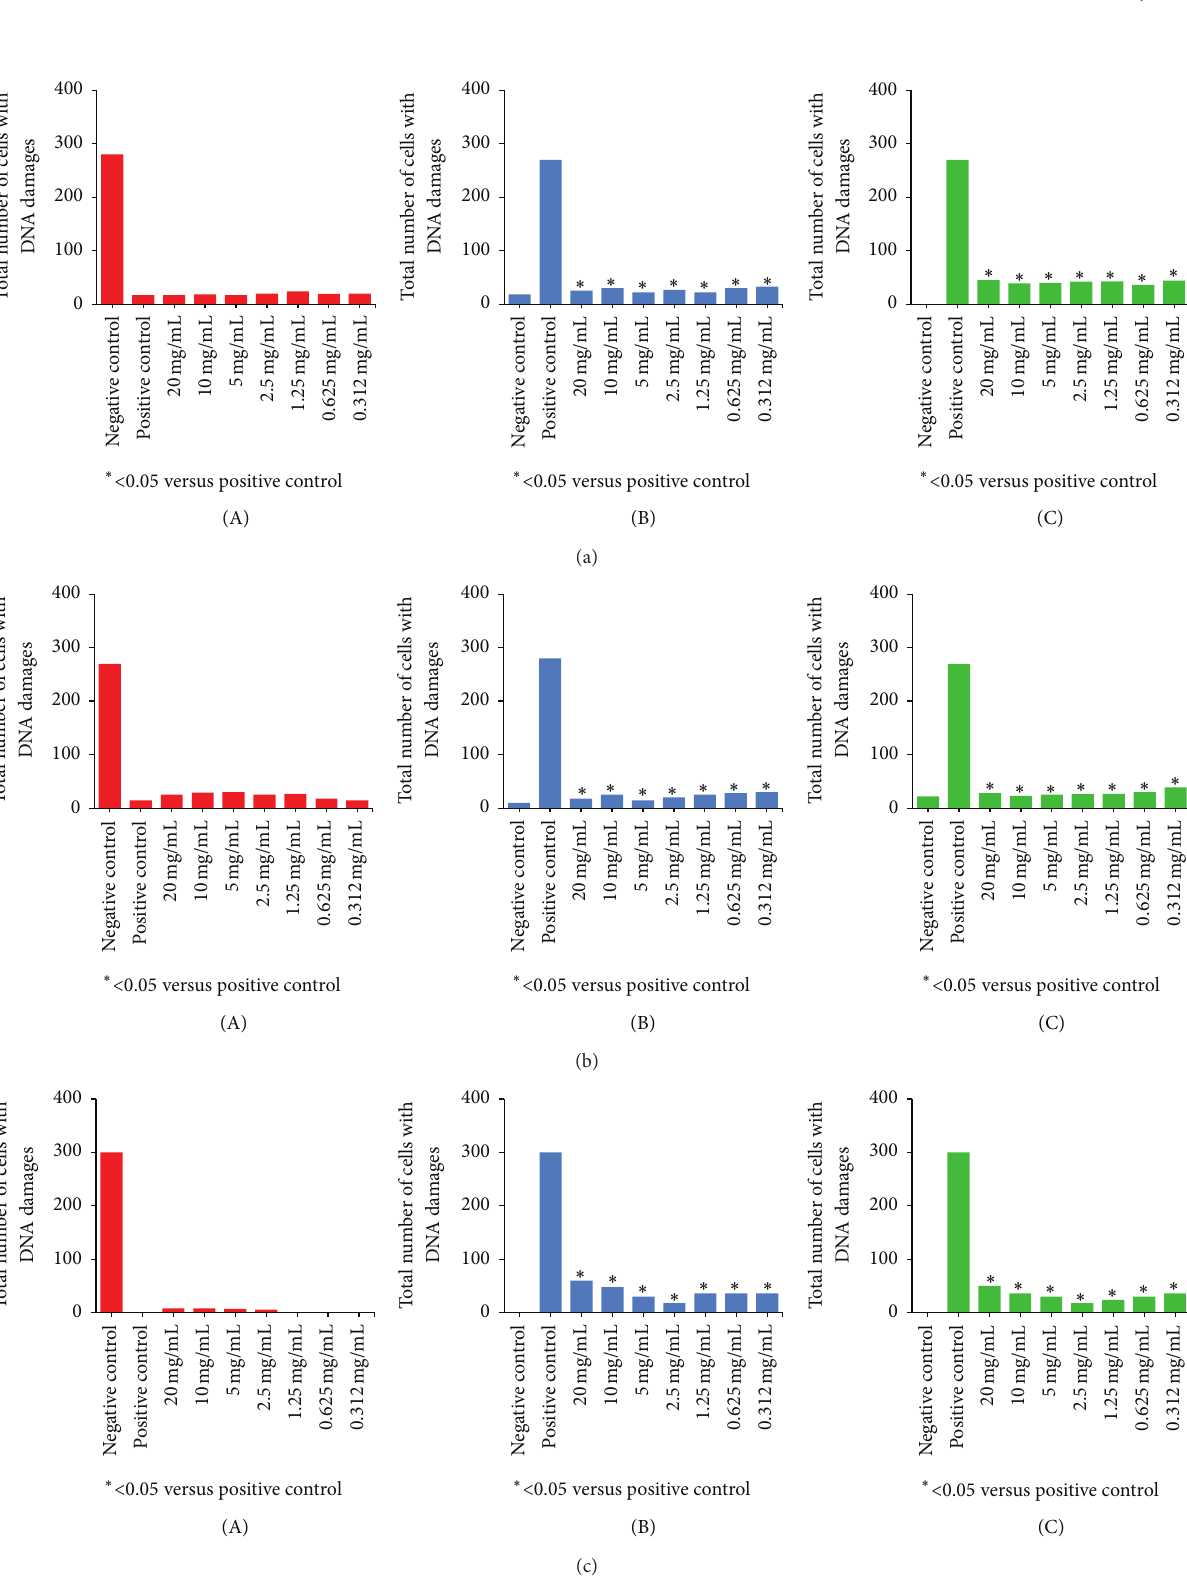
Figure 3: Effect of mycelium extracts of (a) Trametes versicolor, (b) T. hirsuta, and (c) T. gibbosa : (A) genotoxic, (B) antigenotoxic, pretreatment, and (C) antigenotoxic, posttreatment. Three independent experiments with three replicates per experiment were done and evaluated by comet assay. 100 nuclei per each replicate were analyzed. Data represent total number of cells with DNA